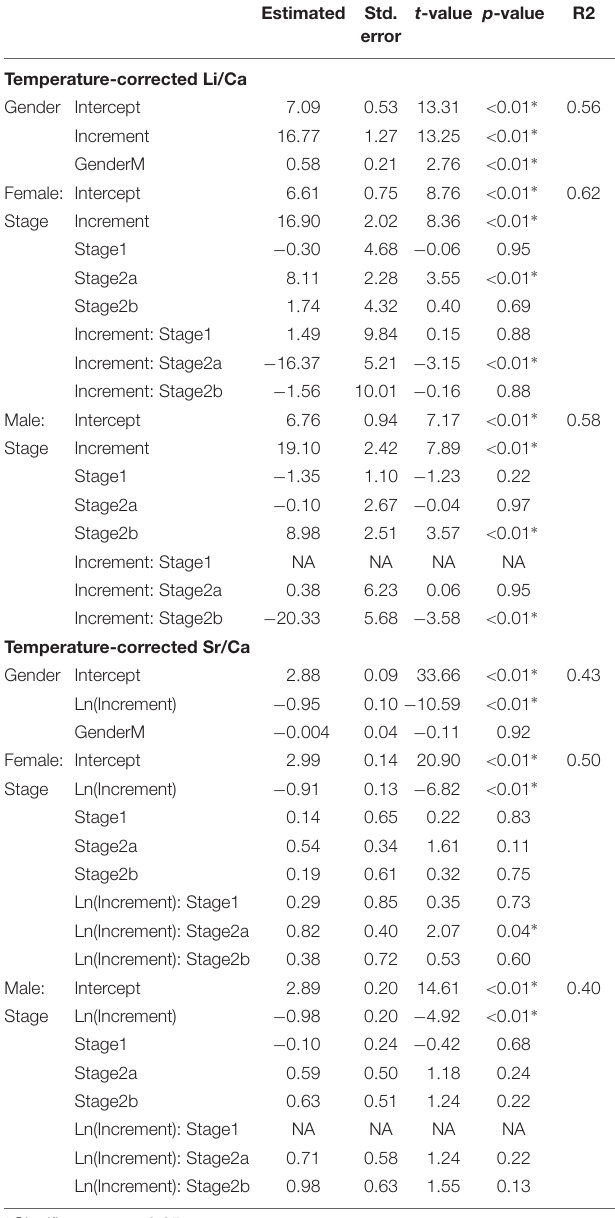
TABLE 4 | Multiple linear regression analyses of temperature-corrected cuttlebone Me/Ca (element/calcium) between sexes and among maturity stages. Estimated Std. t -value p -value error